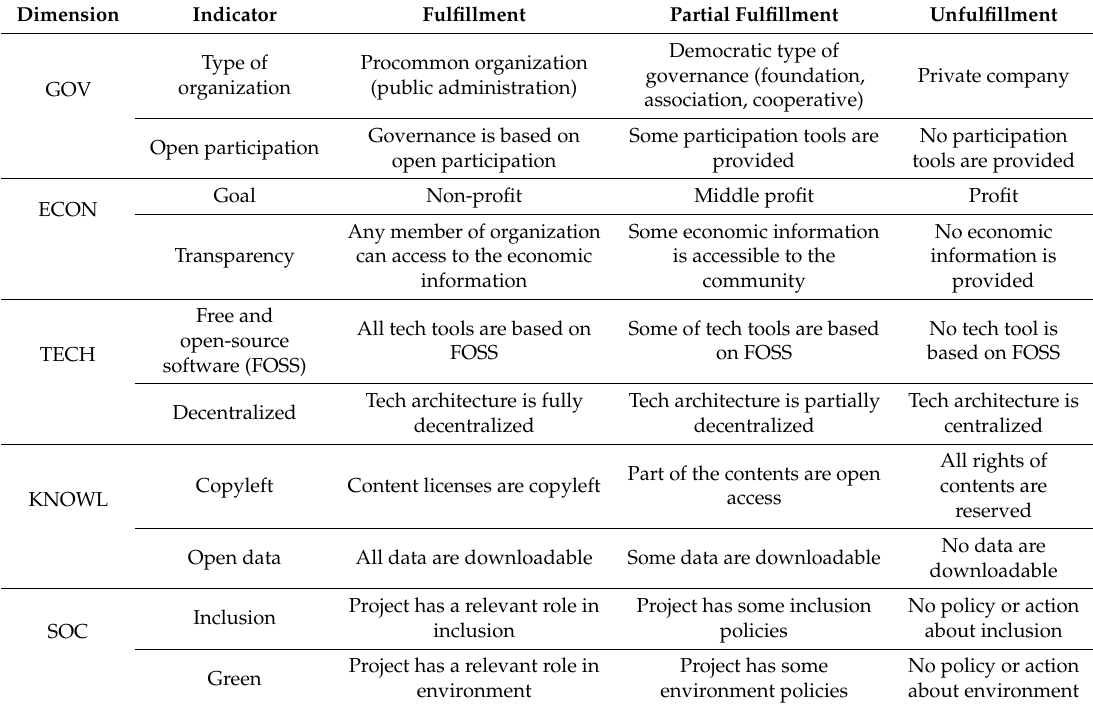
Table 1. Indicators of procommons collaborative economy